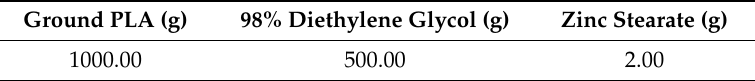
Table 1. Amount of the reactants in the glycolysis